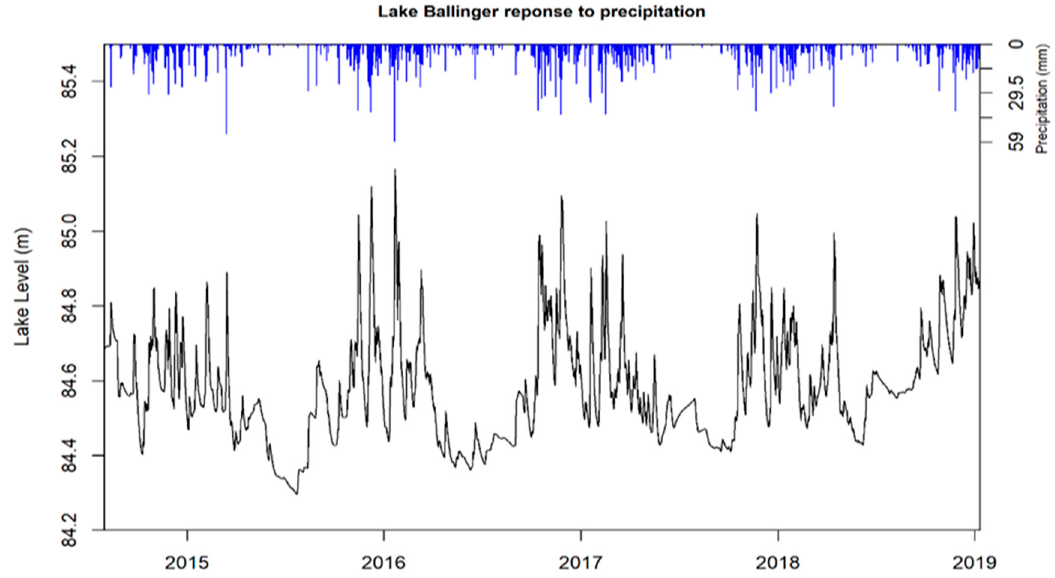
Figure 5. Time series of the Lake Ballinger level and precipitation in the watershed.